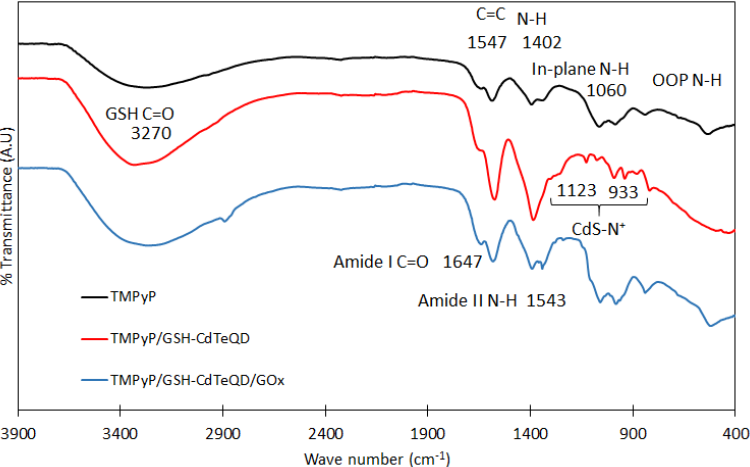
Figure 8. FTIR spectra obtained from the analysis of a modified electrode with TMPyP (black line), TMPyP/GSH-CdTeQD (red line) and TMPyP/GSH-CdTeQD/GOx (blue line).